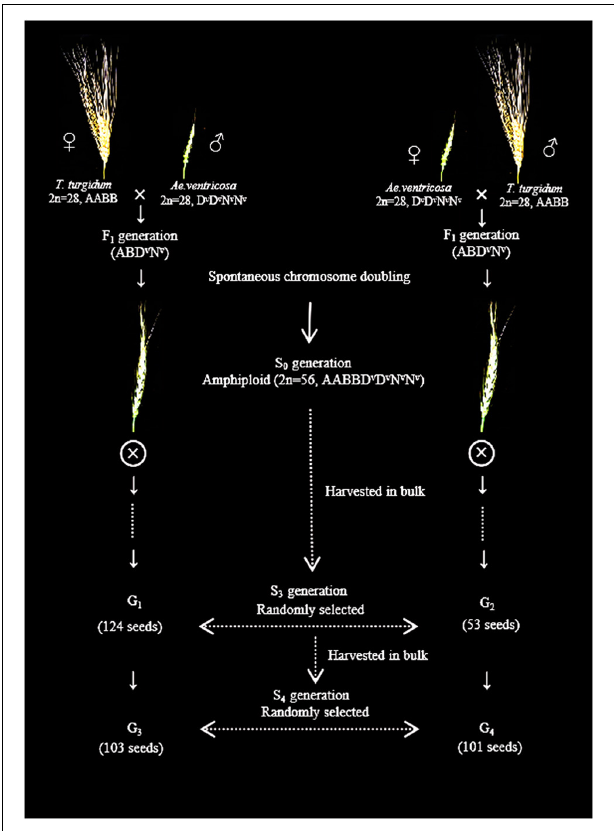
FIGURE 1 | Schematic of strategy used to obtain the experimental seeds (G 1 , G 2 , G 3 , and G 4 ) using hybridization between T. turgidum and Ae.